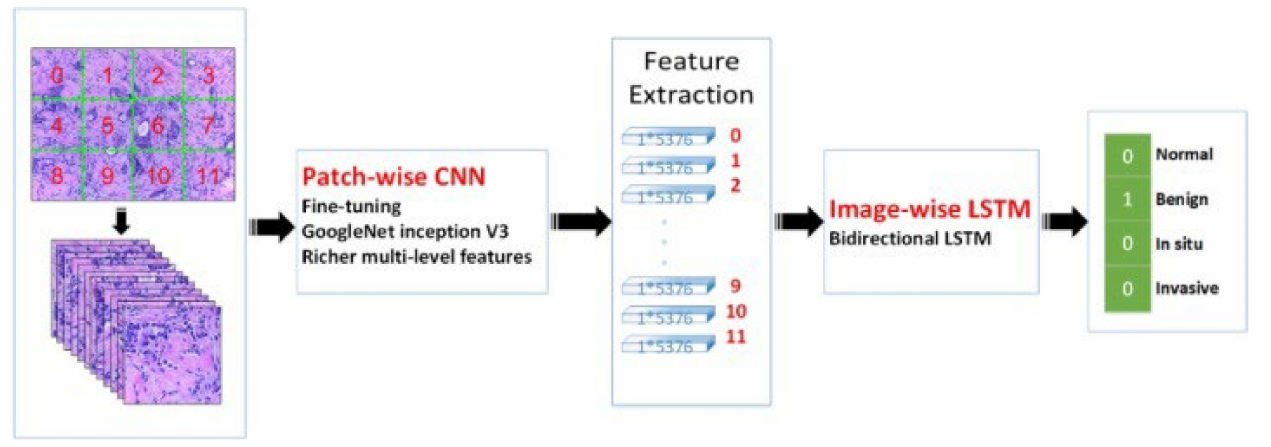
Figure 10. Prediction of breast cancer grades from extracted patches from histopathology images via patch-wise LSTM architecture [264]. Reprinted/adapted with permission from [264]. 2019,